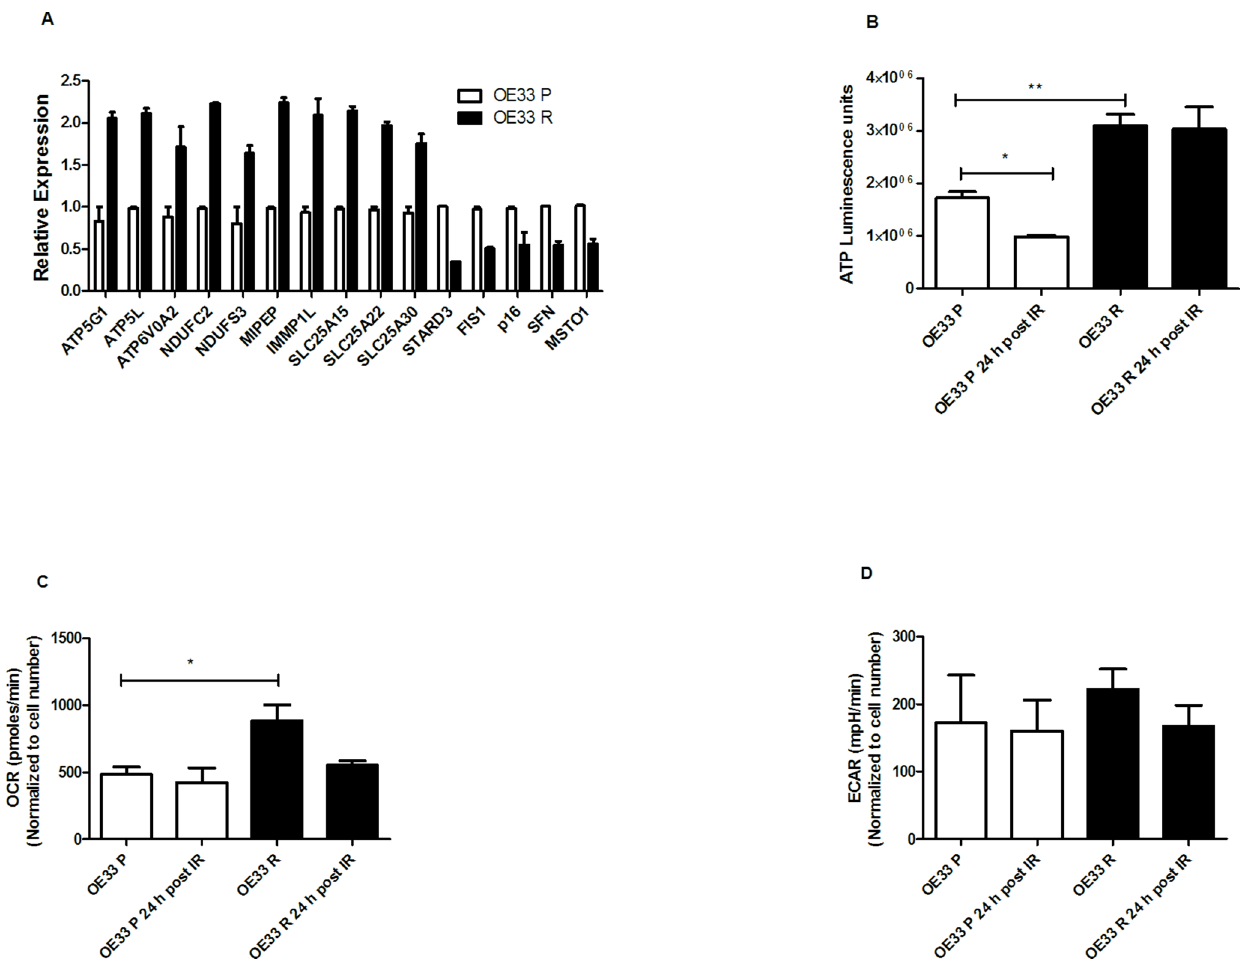
Figure 3. OE33 R cells display alterations in mitochondrial-associated gene expression, total cellular energy and energy metabolism pathways. (A) Basal expression of 15 mitochondrial function and energy metabolism-associated genes were altered 1.5-fold in OE33 R cells, when compared to OE33 P. Data are presented as mean 6 SEM from 2 independent experiments. (B) OE33 R cells have significantly increased basal intracellular ATP levels, when compared to OE33 P. ATP levels significantly decrease in OE33 P cells at 24 h post irradiation with 2 Gy, when compared to basal levels. Data are presented as mean 6 SEM from 1 independent experiment. (C) Basal oxygen consumption rates (OCR) are significantly increased in OE33 R cells, when compared to OE33 P. Data are presented as mean 6 SEM from 4 independent experiments. (D) OE33 R and OE33 P cells demonstrate similar extracellular acidification rates (ECAR). Data are presented as mean 6 SEM from 4 independent experiments. Statistical analysis was performed by 2-tailed Student’s t -test, * P , 0.05, ** P , 0.01.